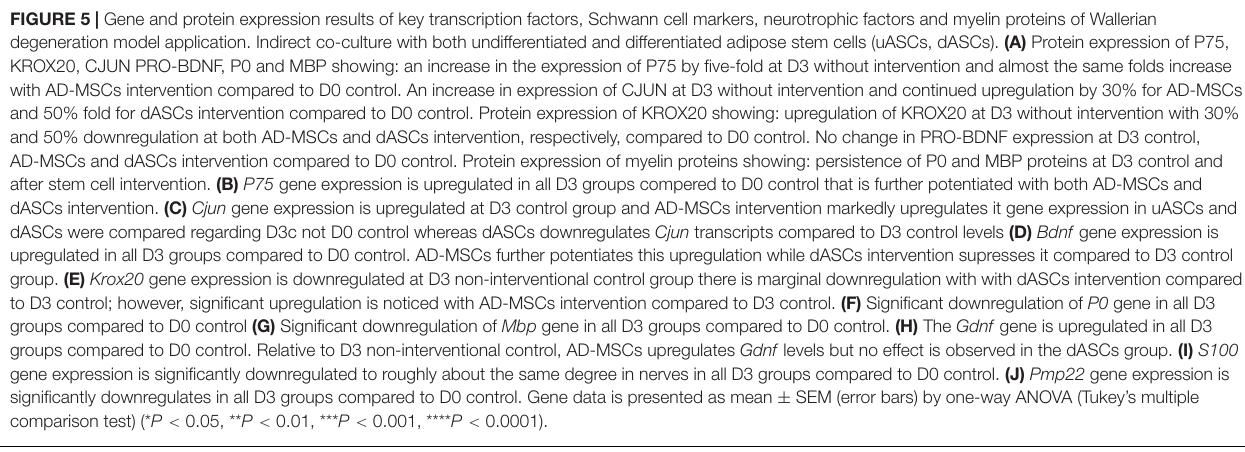
FIGURE 5 | Gene and protein expression results of key transcription factors, Schwann cell markers, neurotrophic factors and myelin proteins of Wallerian degeneration model application. Indirect co-culture with both undifferentiated and differentiated adipose stem cells (uASCs, dASCs). (A) Protein expression of P75, KROX20, CJUN PRO-BDNF, P0 and MBP showing: an increase in the expression of P75 by five-fold at D3 without intervention and almost the same folds increase with AD-MSCs intervention compared to D0 control. An increase in expression of CJUN at D3 without intervention and continued upregulation by 30% for AD-MSCs and 50% fold for dASCs intervention compared to D0 control. Protein expression of KROX20 showing: upregulation of KROX20 at D3 without intervention with 30% and 50% downregulation at both AD-MSCs and dASCs intervention, respectively, compared to D0 control. No change in PRO-BDNF expression at D3 control, AD-MSCs and dASCs intervention compared to D0 control. Protein expression of myelin proteins showing: persistence of P0 and MBP proteins at D3 control and after stem cell intervention. (B) P75 gene expression is upregulated in all D3 groups compered to D0 control that is further potentiated with both AD-MSCs and dASCs intervention. (C) Cjun gene expression is upregulated at D3 control group and AD-MSCs intervention markedly upregulates it gene expression in uASCs and dASCs were compared regarding D3c not D0 control whereas dASCs downregulates Cjun transcripts compared to D3 control levels (D) Bdnf gene expression is upregulated in all D3 groups compared to D0 control. AD-MSCs further potentiates this upregulation while dASCs intervention supresses it compared to D3 control group. (E) Krox20 gene expression is downregulated at D3 non-interventional control group there is marginal downregulation with with dASCs intervention compared to D3 control; however, significant upregulation is noticed with AD-MSCs intervention compared to D3 control. (F) Significant downregulation of P0 gene in all D3 groups compared to D0 control (G) Significant downregulation of Mbp gene in all D3 groups compared to D0 control. (H) The Gdnf gene is upregulated in all D3 groups compared to D0 control. Relative to D3 non-interventional control, AD-MSCs upregulates Gdnf levels but no effect is observed in the dASCs group. (I) S100 gene expression is significantly downregulated to roughly about the same degree in nerves in all D3 groups compared to D0 control. (J) Pmp22 gene expression is significantly downregulates in all D3 groups compared to D0 control. Gene data is presented as mean ± SEM (error bars) by one-way ANOVA (Tukey’s multiple comparison test) (* P < 0.05, ** P < 0.01, *** P < 0.001, **** P <